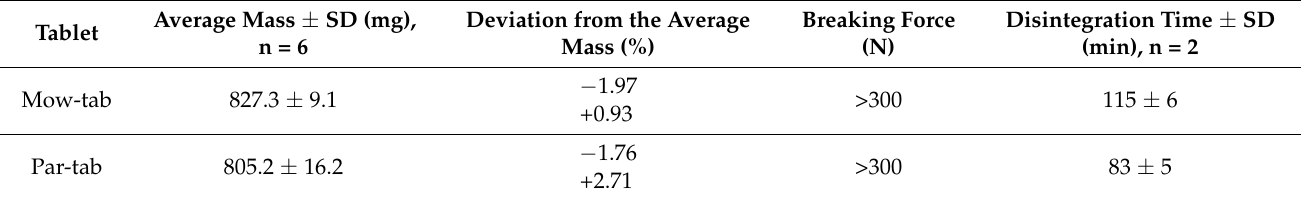
Table 4. Summary of pharmaceutical evaluation of 3DP